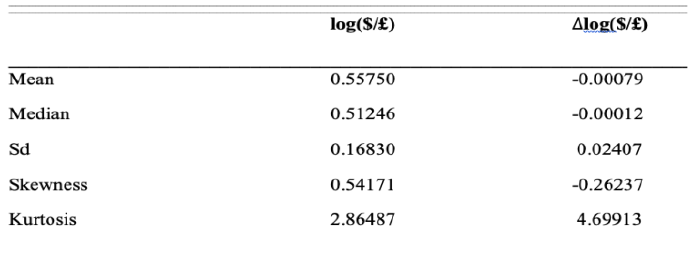
Table 1: Descriptive statistics for log($/£) and ∆ log($/£)